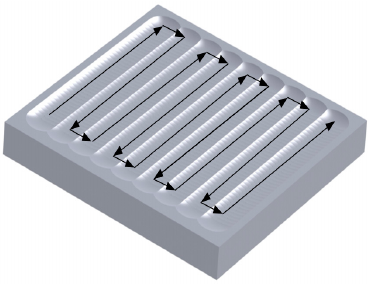
Figure 9. Schematic diagram of UIP processing trajectory. Table 2. Parameters of UIP experiment.